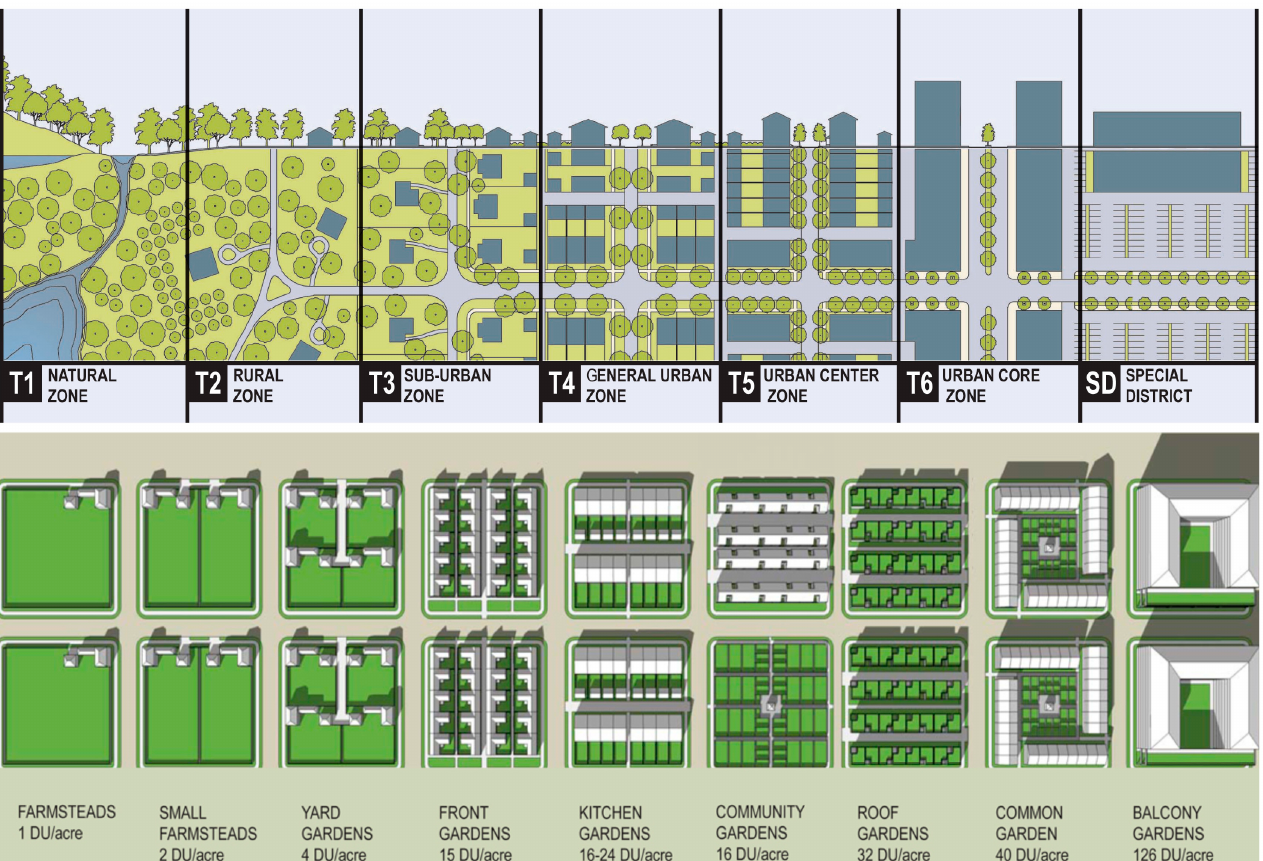
Figure 6. Duany’s version of the transect ( above ) and matrix of building types ( below ), central elements of his Agrarian Urbanism concept. Image courtesy of DPZ CoDesign.